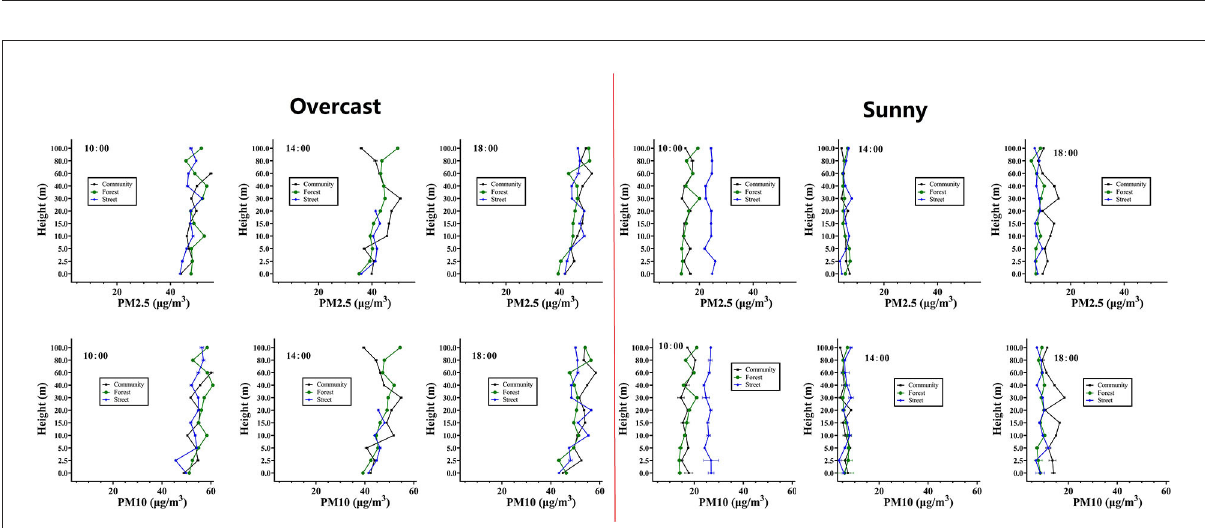
FIGURE2 Hourly vertical distributions of PM 2.5 (particulate matter with diameter less than 2.5 µ m) and PM 10 (particulate matter with diameter less than 10 µ m) concentrations (mean ± SE) in the overcast and sunny days,